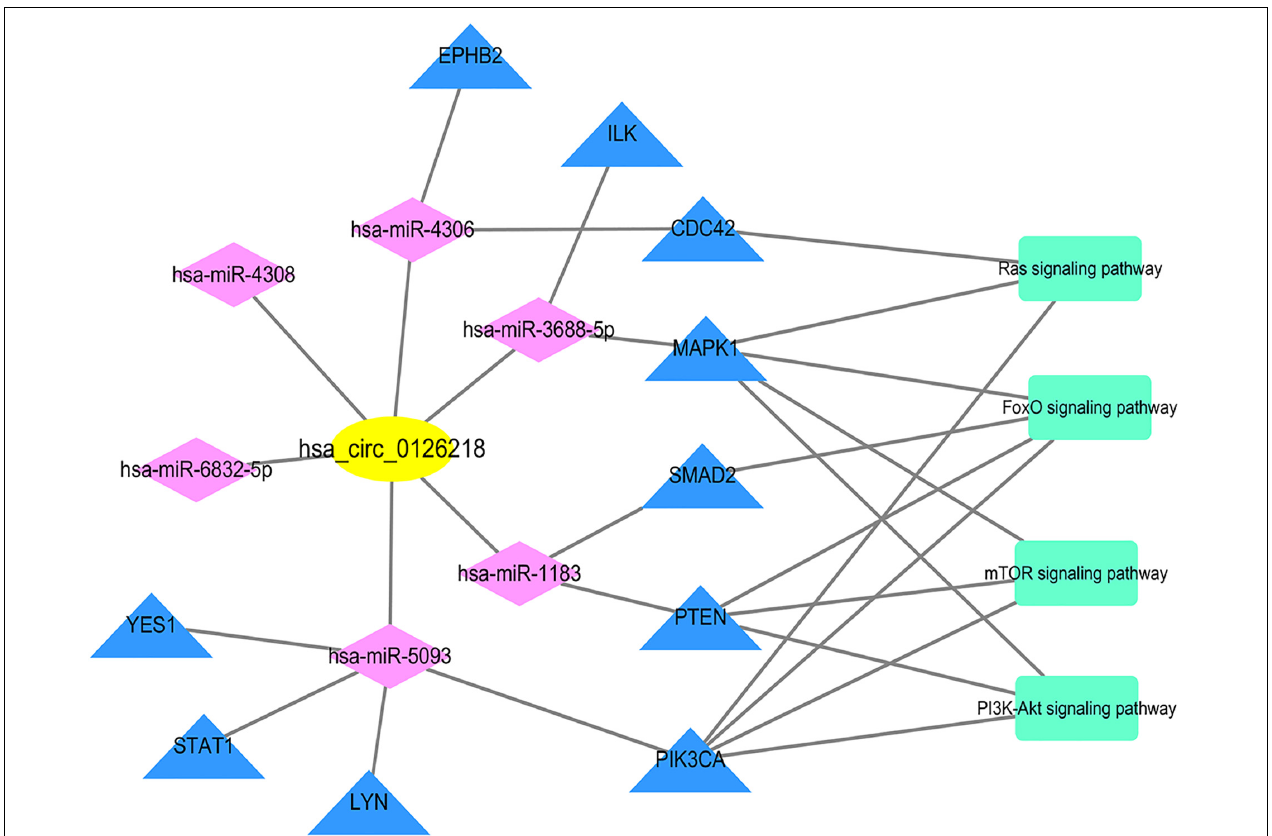
FIGURE 8 | Subnetwork. The subnetwork contains 1 verified circRNA, 6 predicted miRNA and 10 screened out hub genes. Yellow color indicates circRNA, purple color presents miRNA, blue color illustrates mRNA and green color illustrates signaling pathway. circRNA, circular RNA; miRNA,